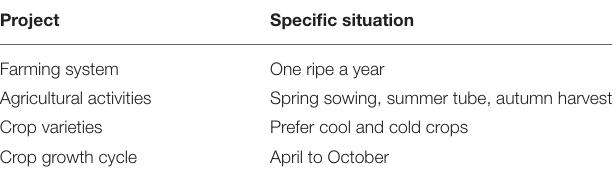
TABLE 1 | Characteristics of agricultural planting in the three northeast